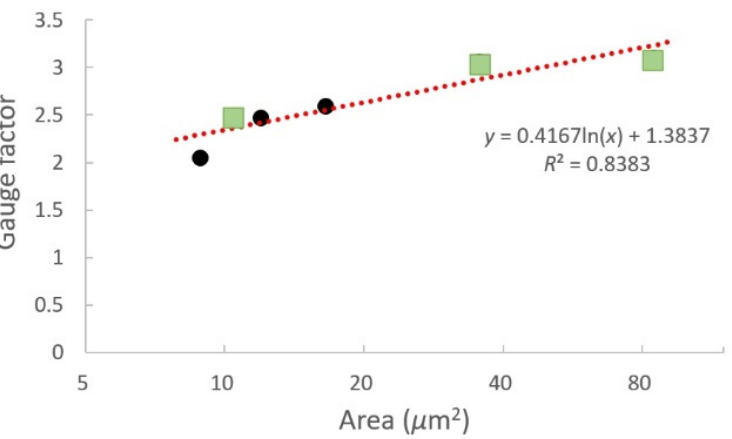
Figure 8. Gauge factor as a function of the width of printed strain-gauge patterns: ( a ) 2.047 for two droplets, ( b ) 2.471 for four droplets and ( c ) 2.589 for seven droplets.